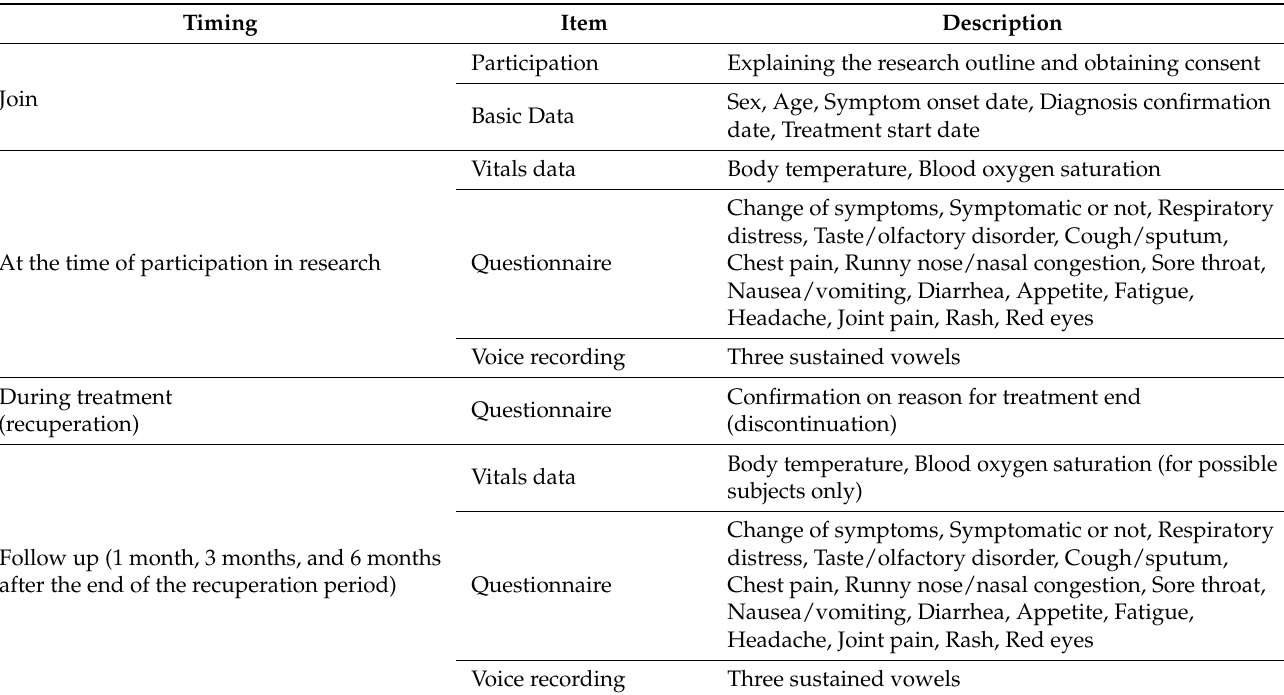
Table 2. Data collected from the